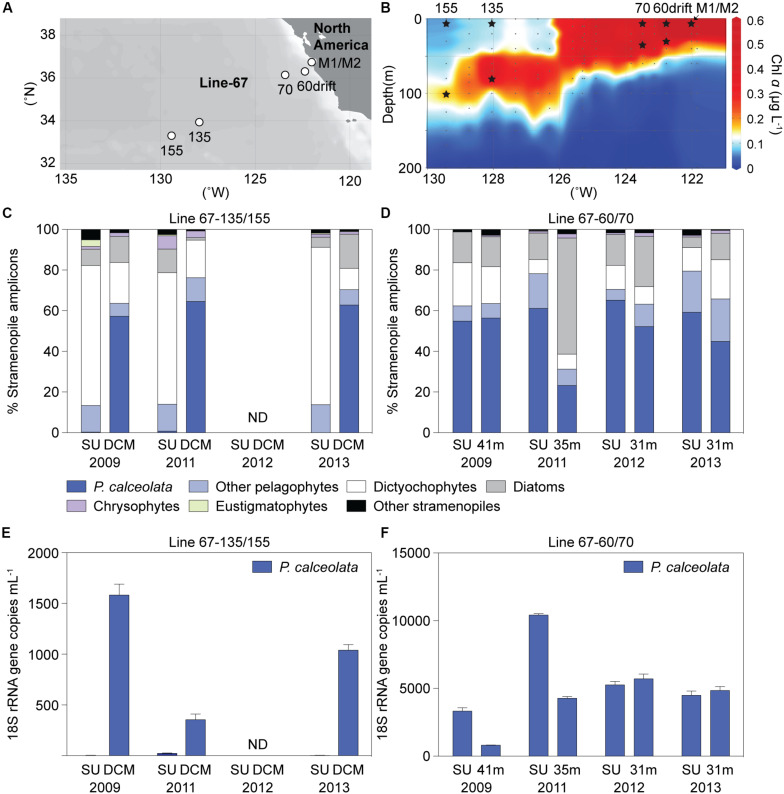
ENP (A) stations and (B) chlorophyll a depth profile in 2009 with sampling for DNA indicated by stars (Stations 67-60drift and 67-70, mesotrophic sites; Stations 67-135 and 67-155, oligotrophic sites). Relative abundance of stramenopile V1-V2 16S rRNA gene amplicons assigned to the Pelagomonas calceolata Clade or other groups in Line-67 samples. (C) Taxon distributions at sites with well stratified water columns where nitrate was 0.02 and 0.08 μM (plus 1 sample < 30 nM detection limit) at the surface and 0.05 to 0.3 μM (0.17 ± 0.13 μM, n = 3) in the deep chlorophyll maximum (DCM). (D) Distributions in surface (SU, 2–14 m) or near the base of the photic zone (31-41 m) at mesotrophic sites. (E,F)
P. calceolata 18S rRNA gene copies ml–1 enumerated by qPCR in the same samples as analyzed for panels C, D. Note the different scale on the y-axis in (E) and (F). ND: no data. Error bars represent the standard deviation of three technical replicates.